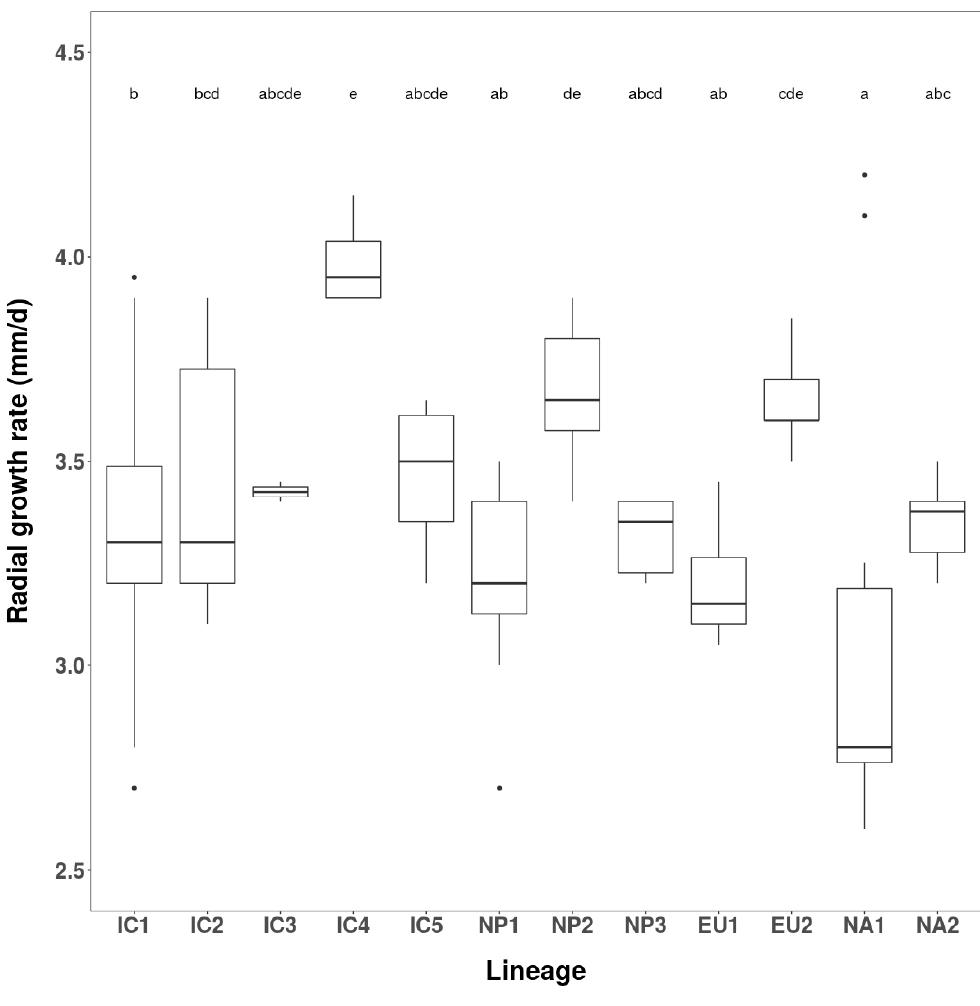
Figure 4. Box and whiskers diagram showing daily radial growth rates of the eight Asian phenotype groups and four known lineages of Phytophthora ramorum at 20 °C on carrot agar (CA). Different letters indicate statistical differences at significance level α = 0.05 .